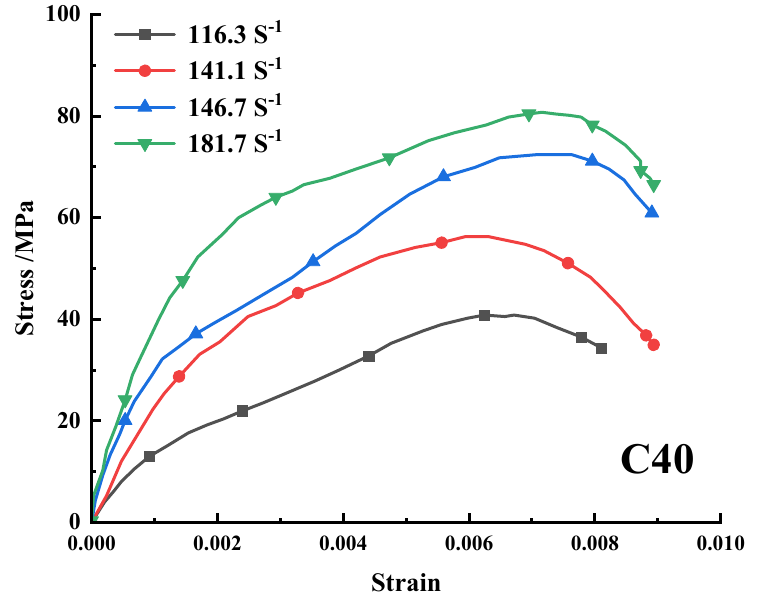
Figure 9. Stress–strain curves for HPC (C40) under various loading rates at a high temperature of 300 °C.